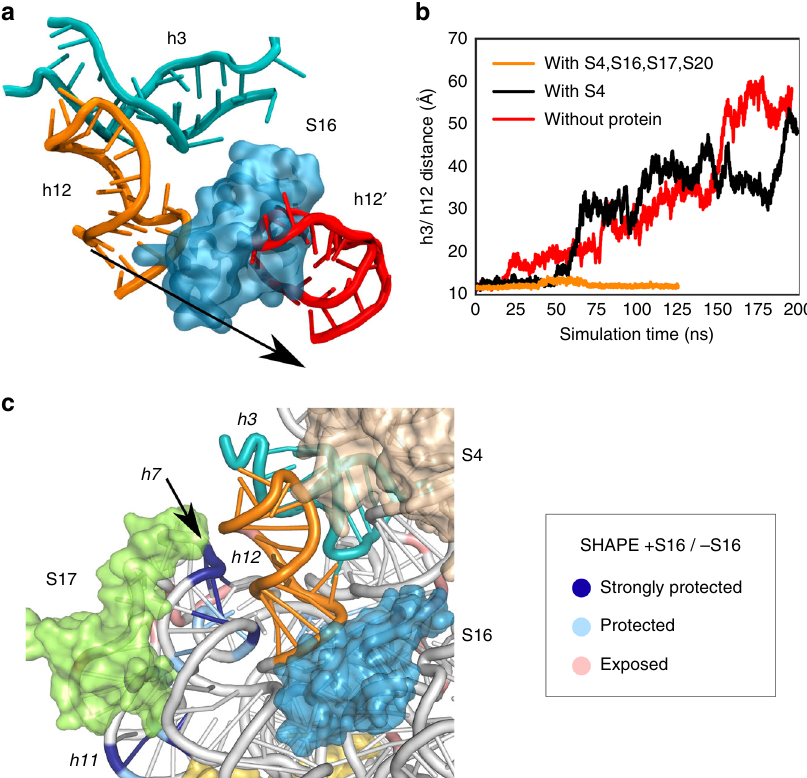
Fig. 5 Molecular dynamics simulation of 5 ’ domain. a Snapshots from two molecular dynamics trajectories of h3 ( cyan ) and h12 ( red : without protein; orange : with S4, S16, S17, S20). b Center of mass distance between residues at the interface of h3 and h12. When S16 is bound to the 5 ′ domain, h12 is pressed against h3 and the two helices remain packed together. Without S16, however, h12 becomes more pliable and dissociates from h3, causing the helix conformation to deviate from the crystallographic structure (Supplementary Fig. 5). c Differences in SHAPE modi fi cation caused by protein S16. SHAPE chemical modi fi cation of the ribose 2 ′ OH increases with backbone fl exibility and accessibility. Colors show the relative 5 ′ domain RNA modi fi cation ρ in the presence of S4, S16, S17 and S20 (+S16) compared to S4, S17, and S20 ( – S16): dark blue, strongly protected (log( ρ